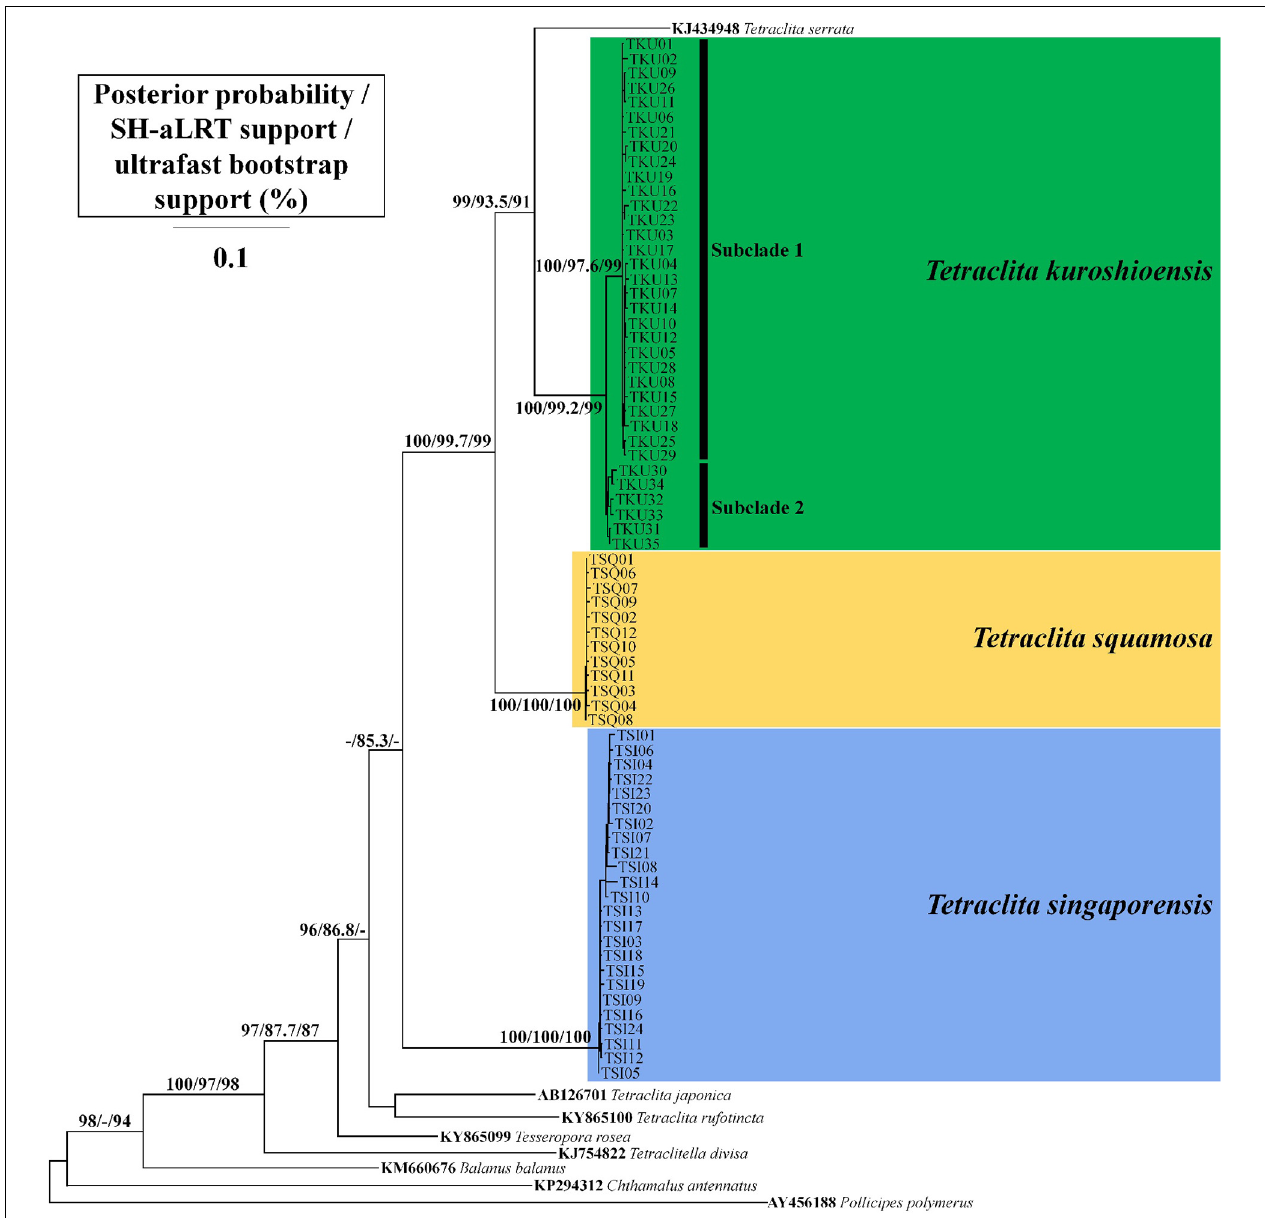
FIGURE 4 | Phylogenetic tree of Tetraclita spp. in Thailand based on the CO1 and 12S rRNA concatenated sequences by maximum likelihood (ML). Posterior probability for Bayesian inference (BI), SH-aLRT, and ultrafast bootstrap support for ML are presented at the main nodes when >